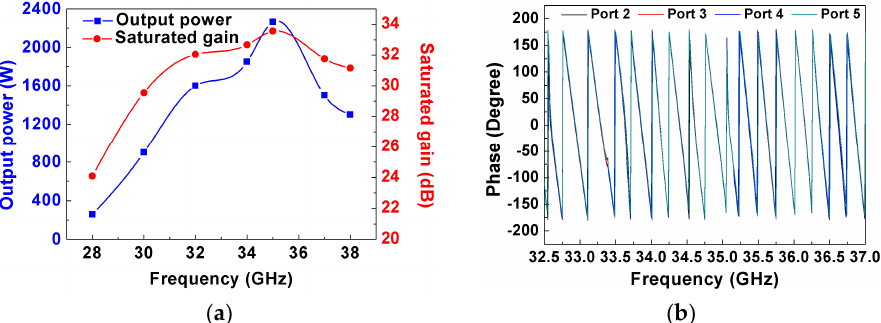
( c ) Figure 10. Fabricated cavity for the transmission model with the input port at the front ( a ); the output ports at the back ( b ); the dimensions ( c ).